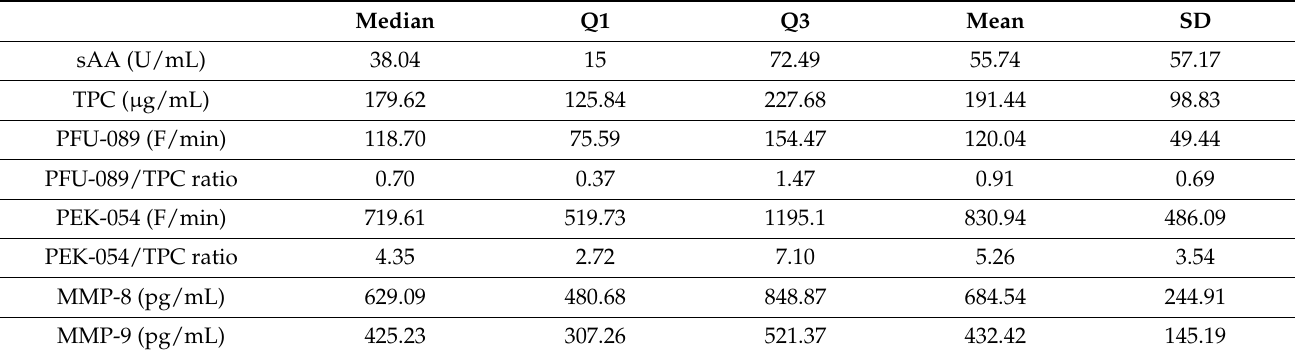
Table 2. Values of Salivary Proteins and Enzymatic